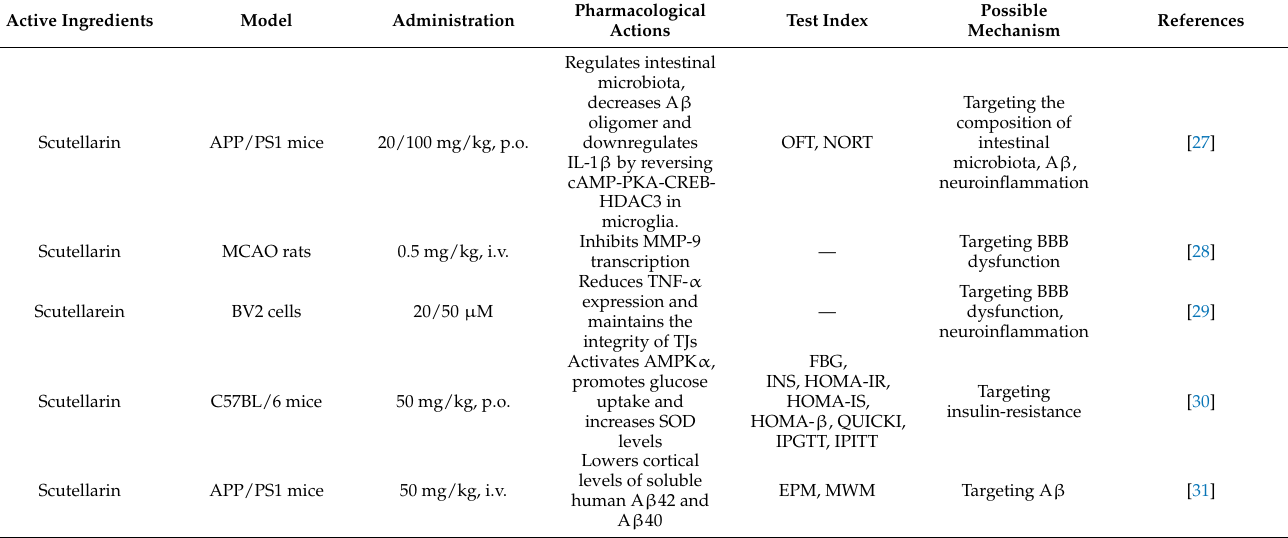
Table 1. The pharmacology and probable mechanisms of EBHM’s compounds and metabolism for treating